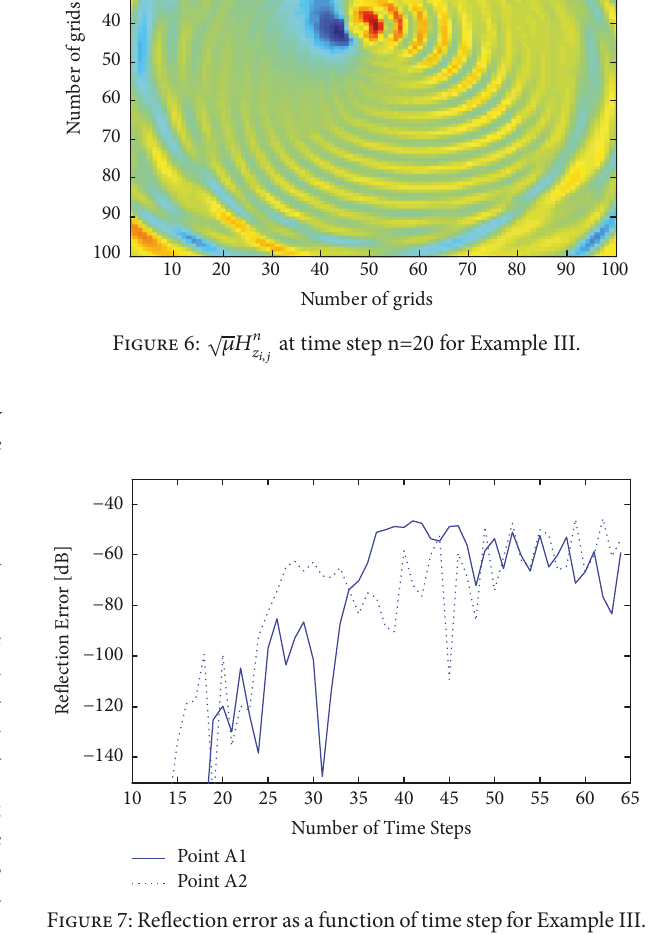
Figure 7: Reflection error as a function of time step for Example